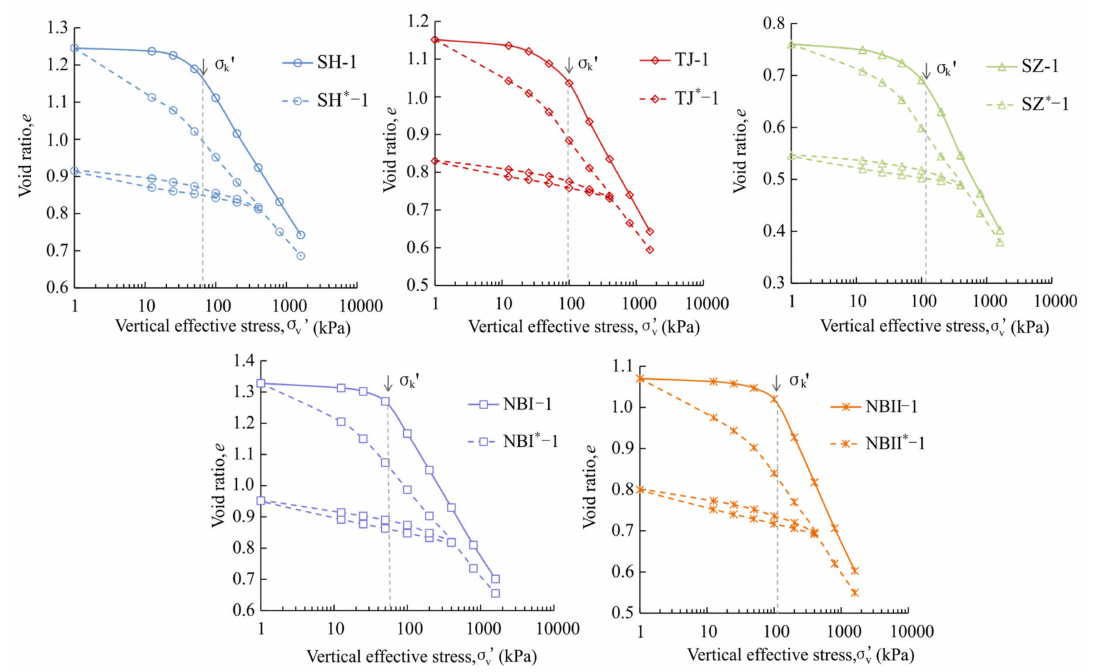
Figure 5. Compression curves for undisturbed and remolded